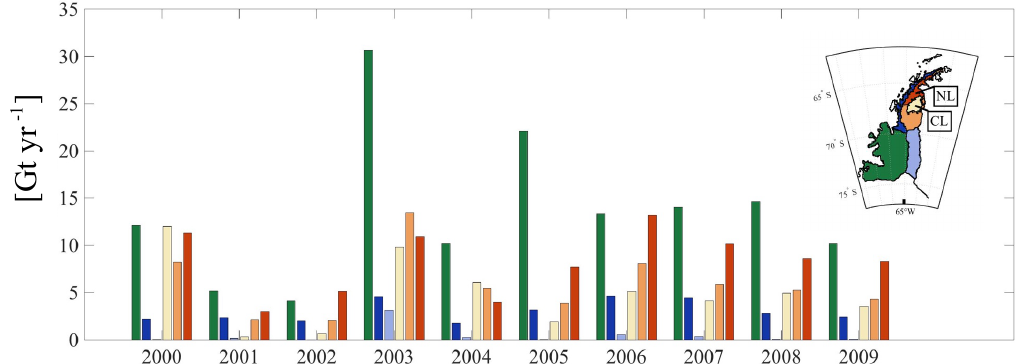
Figure 2. Annual meltwater production from MAR [Gtyr − 1 ] shown for masks shown in inset (“2001” corresponds to meltwater production from July 2000–June 2001. NW, SW, and SE basins are shown as in Fig. 1. NE basin is divided into the NL mask, the CL mask and the remaining portion of the NE basin (NE − (CL + NL)). The CL and NL masks are described in